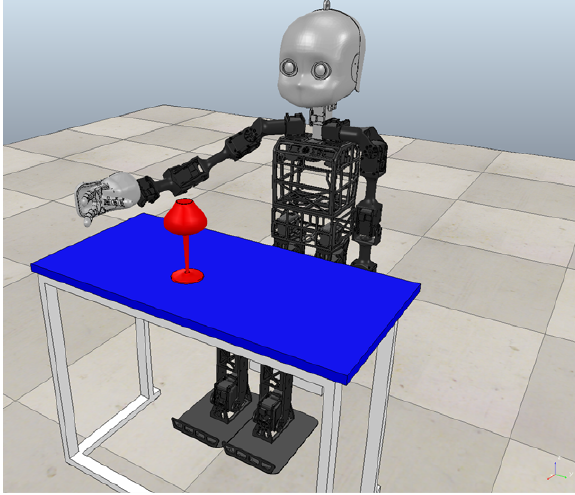
Figure 6: The V-REP simulation environment used in the second experiment including the NICO humanoid sitting in front of a table on top of which a target object is placed. NICO learns to grasp the object with its right multi-fingered hand.